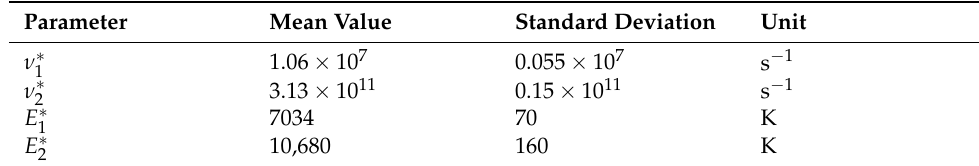
Table A2. New parameters of the model based on experimental data from the plant with the associated standard